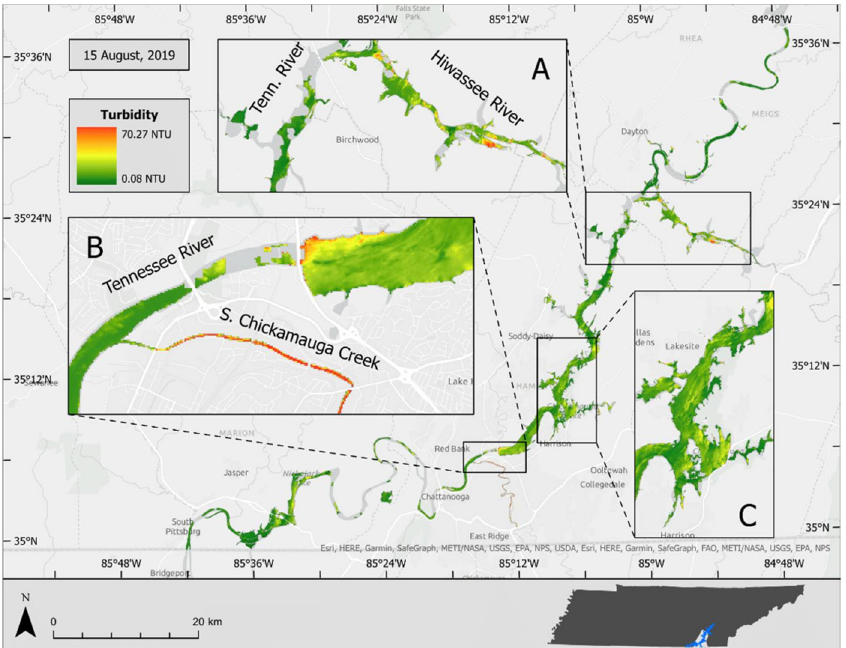
Figure 11. Turbidity estimated on 15 August 2019 by the turbidity estimation model. The insets highlight areas of high turbidity variability due to the convergence of lakes and streams. Site A details the confluence of the Tennessee and Hiwassee Rivers, Site B highlights the increased turbidity of South Chickamauga Creek, and Site C details the Harrison Bay area.